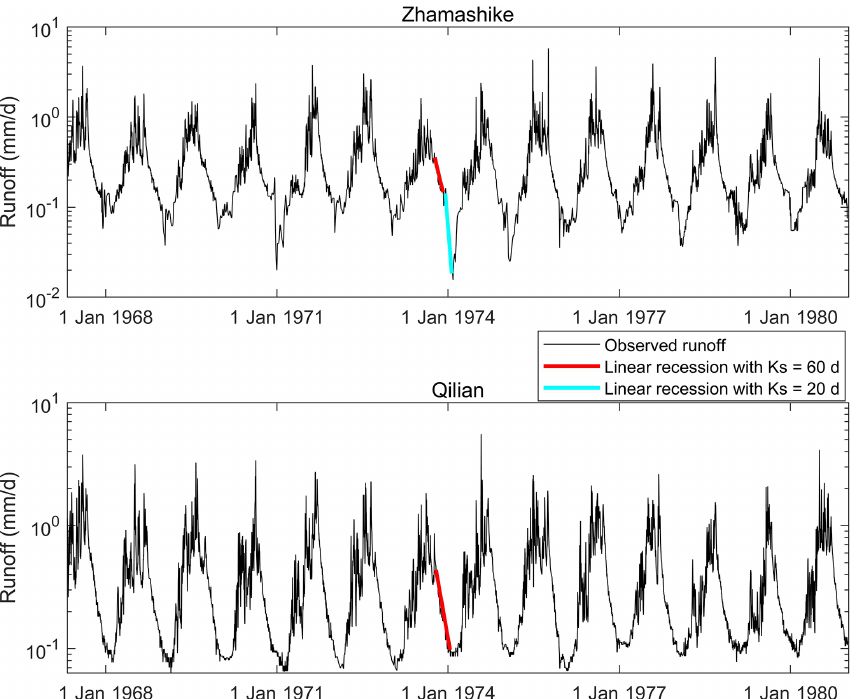
Figure 6. The hydrograph of the Zhamashike and Qilian subbasin on logarithmic scale, and the linear recession curve with K s = 60d and K s =